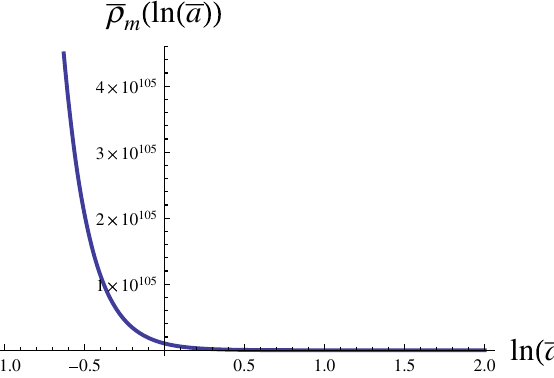
Fig. 4 Illustration of the typical evolution of ¯ ρ m with respect to ln ( ¯ a ) at the beginning of the inflation epoch. We assume that γ = 1 . 16 × 10 − 69 s 2 and ¯ a 0 = 1 at the beginning of the inflation epoch. ¯ ρ m is expressed in units of km 2 s 2 Mpc